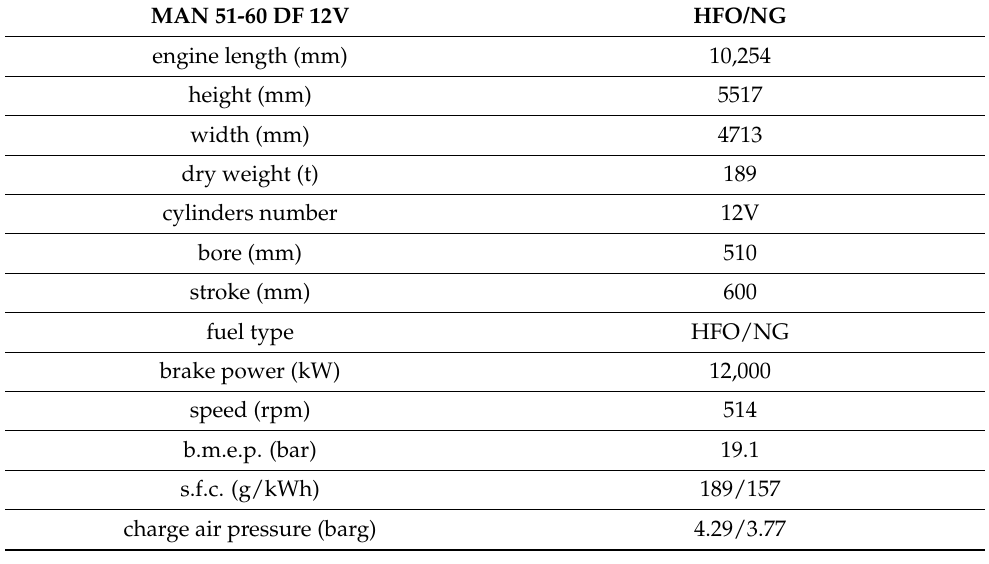
Table 1. Engine dimensions and design data [21].